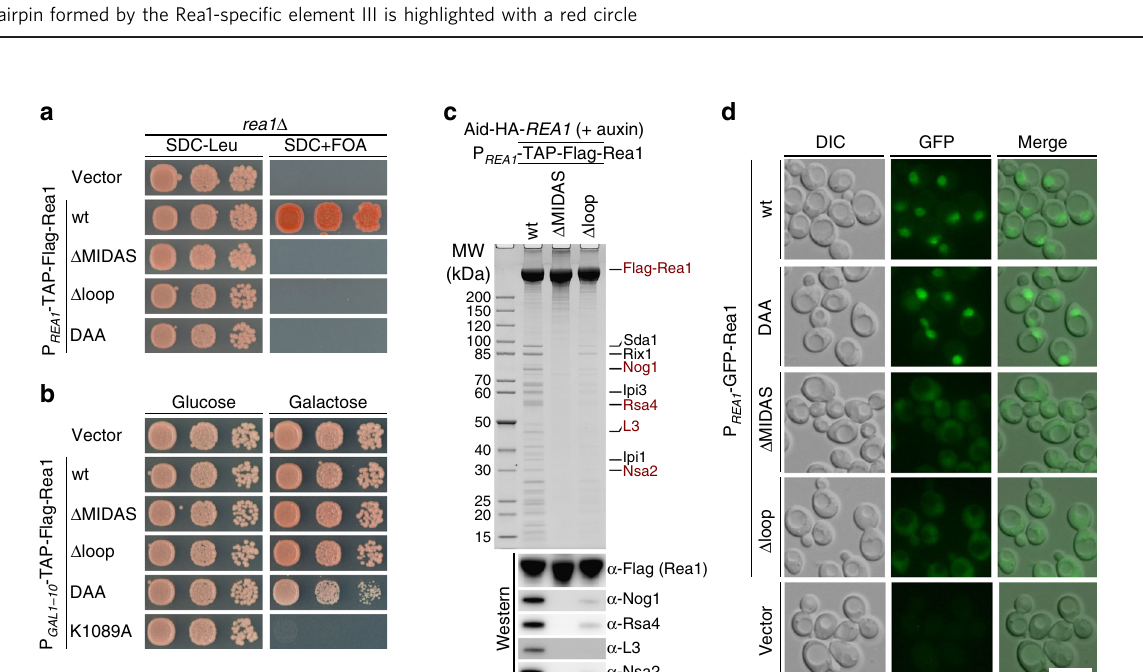
Fig. 3 The Rea1-MIDAS-speci fi c element III forms a novel interaction site with the UBL domain. a Crystal structure of the Ct Rea1-MIDAS Δ loop Ct Rsa4-UBL complex (left panel) and close-up of the interaction between the MIDAS element III and the Rsa4-UBL domain (right panels). The residues selected for mutational analysis are indicated. b Multiple sequence alignment of Rea1 showing the Rea1-MIDAS-speci fi c element III. Sequences of Chaetomium thermophilum ( Ct ), Saccharomyces cerevisiae ( Sc ), Schizosaccharomyces pombe ( Sp ), Kluyveromyces lactis ( Kl ), Arabidopsis thaliana ( At ), Dictyostelium discoideum ( Dd ), Mus musculus ( Mm ), and Homo sapiens ( Hs ) were aligned with Clustal Omega and visualized with Jalview. The element III with its two β - sheets are indicated in red, and residues mutated in this study are shown above the alignment (red: C. thermophilum , black: S. cerevisiae ). c , d Yeast two- hybrid analysis between the indicated Rea1-MIDAS constructs and full-length Rsa4 from C. thermophilum ( c ) and S. cerevisiae ( d ). The MIDAS constructs were fused to an N-terminal GAL4-BD and the Rsa4 constructs to an N-terminal GAL4-AD. The constructs were co-transformed into yeast (PJ69-4A) and cells were spotted on SDC (SDC-Leu-Trp) and SDC-His (SDC-Leu-Trp-His) plates. Cell growth was inspected after 3 days at 30 °C. e The indicated Rea1 constructs were transformed in a rea1 Δ shuf fl e strain. After plasmid shuf fl ing on SDC plates containing 5-FOA, cells were spotted on YPD plates and growth was monitored at the indicated temperatures and times. f The rea1 Δ rsa4 Δ and rea1 Δ ytm1 Δ double shuf fl e strains were transformed with the indicated wild-type and mutant constructs. Transformants were spotted on SDC (SDC-Leu-Trp) and SDC + FOA plates and cell growth at 30 °C was monitored after 3 and 5 days, respectively. g Electron density map of the Rix1 – Rea1 particle (EMD-3199) and the models of Rsa4 and Rea1 (PDB ID: 5JCS) in purple and orange, respectively. A density not occupied by the model is highlighted with a red circle (upper close-up). The lower close-up views show the rigid body fi t of the Rea1-MIDAS Δ loop – Rsa4-UBL complex from C. thermophilum within the electron density map of the Rix1 – Rea1 particle (EMD-3199). The β -hairpin formed by the Rea1-speci fi c element III is highlighted with a red circle